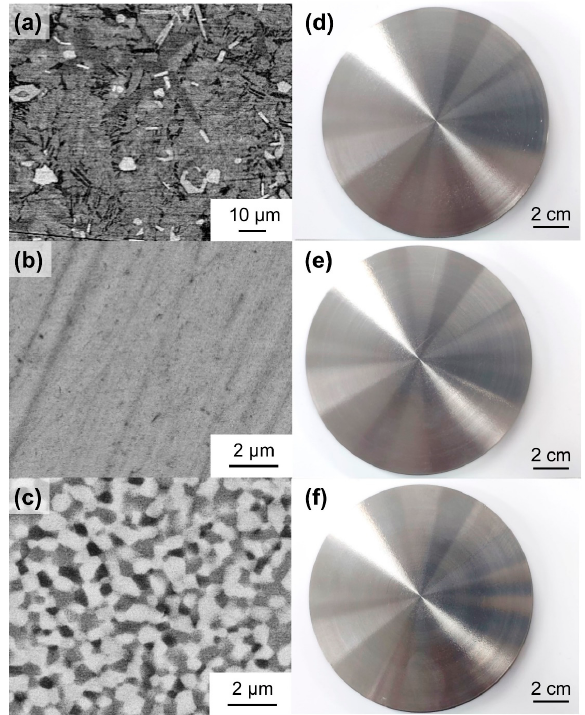
Figure 4. ( a – c ) SEM results for surfaces before TFMG deposition of the ( a ) cast target, ( b ) amorphous target, and ( c ) crystalline target, respectively. ( d – f ) Surface photographs before TFMG deposition of ( d ) cast target, ( e ) amorphous, and ( f ) crystalline targets, respectively.